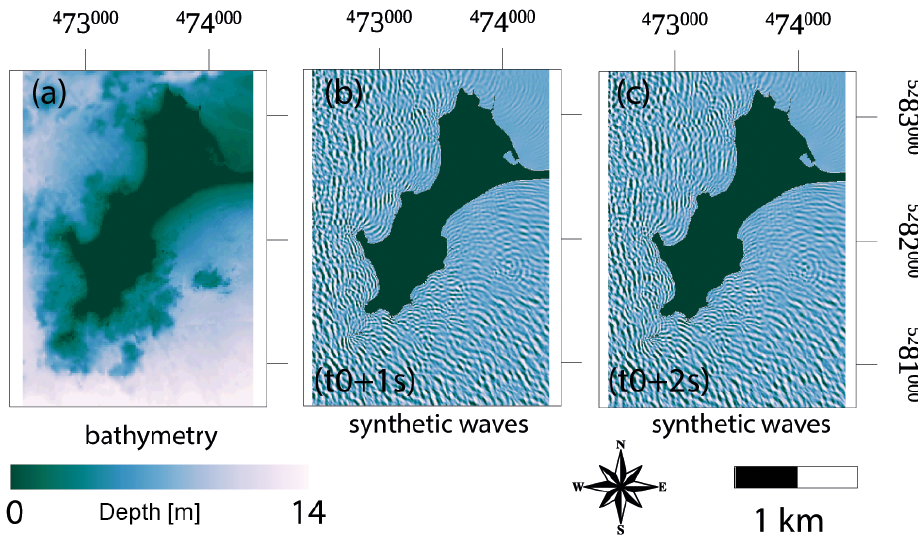
Figure 1. Study area and an example Sentinel 2 sub-image (band 4). The square represents a histo- gram-stretched cut of the image, highlighting the waves therein. Coordinates are expressed in UTM N30 .